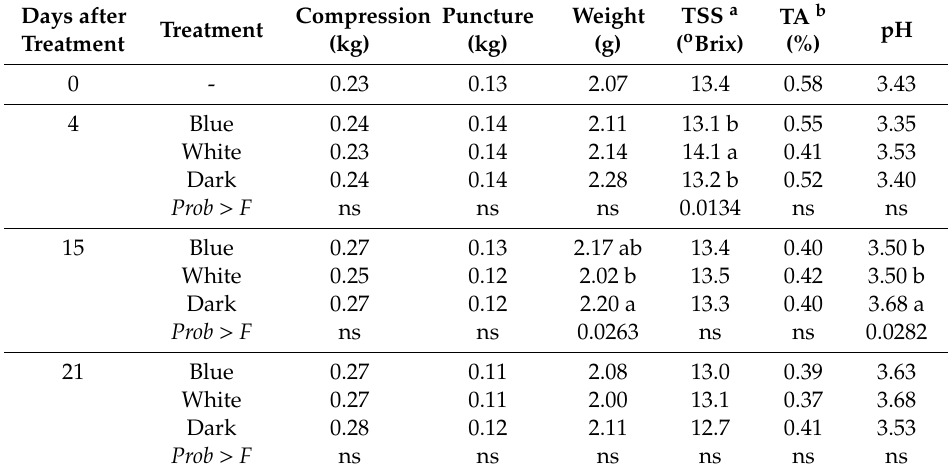
Table 1. Quality attributes of ripe ‘Star’ southern highbush blueberries subjected to light treatments at various times during cold storage.